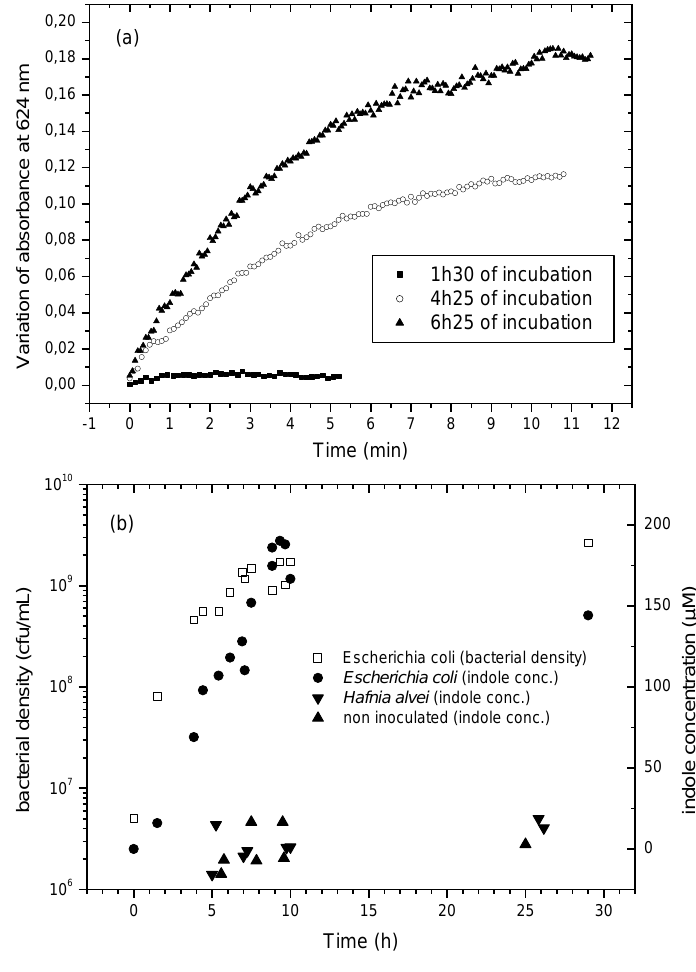
Figure 2. Detection of indole released by E. coli bacteria in Lysogeny Broth (LB) media at 37 °C. ( a ) Variation of the absorbance of pastille at 624 nm vs. time. It reveals the kinetics of formation of the azafulvenium chloride salt in the nanoporous sensor at different incubation times; ( b ) Left ordinate: Bacterial density in the nutrient phase as a function of incubation time for E. coli . Right ordinate: indole concentration in the nutrient phase for E. coli , H. alvei and a blank